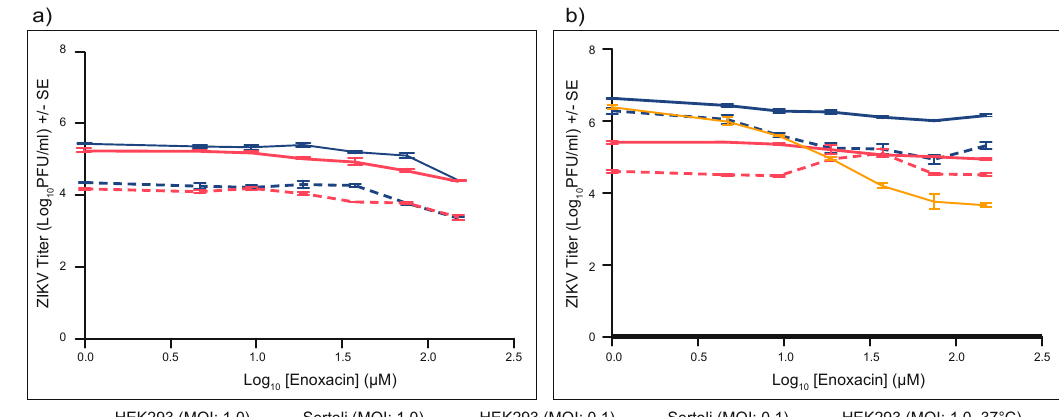
Figure 6. Enoxacin does not suppress ZIKV in mouse Sertoli cells two days pi ( a ) or five days pi ( b ). Dose-response curves for enoxacin and ZIKV titer at 32 °C in Sertoli cells (pink) and HEK-293 cells (blue) at two MOI, 0.1 (dashed) and 1.0 (solid). Dose-response curve for enoxacin and ZIKV titer in HEK-293 cells at 37 °C (yellow) is included for comparison on day 5 p.i. Statistical analysis is described in the text.